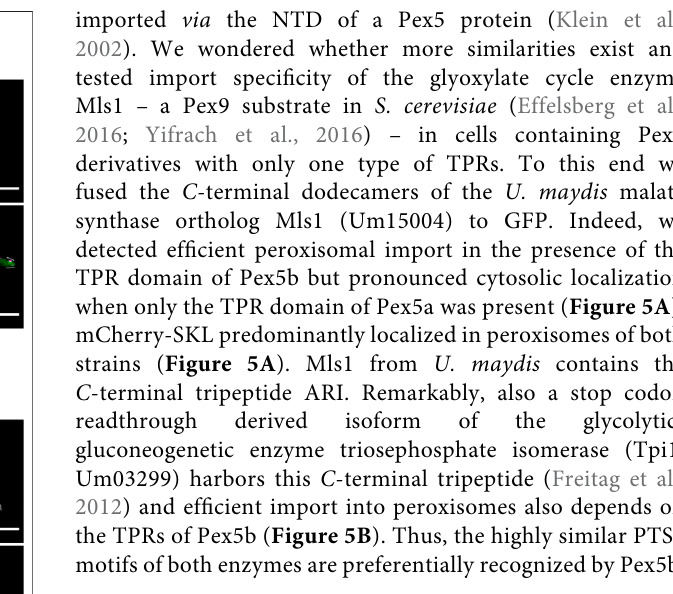
( Figure 3C ) . Together, the results of the two-hybrid assay con fi rm that TPR domains of Pex5a and Pex5b show distinct preferences for variations of the C -terminal targeting signal and indicate that both cargo receptors have speci fi c as well as shared substrates.